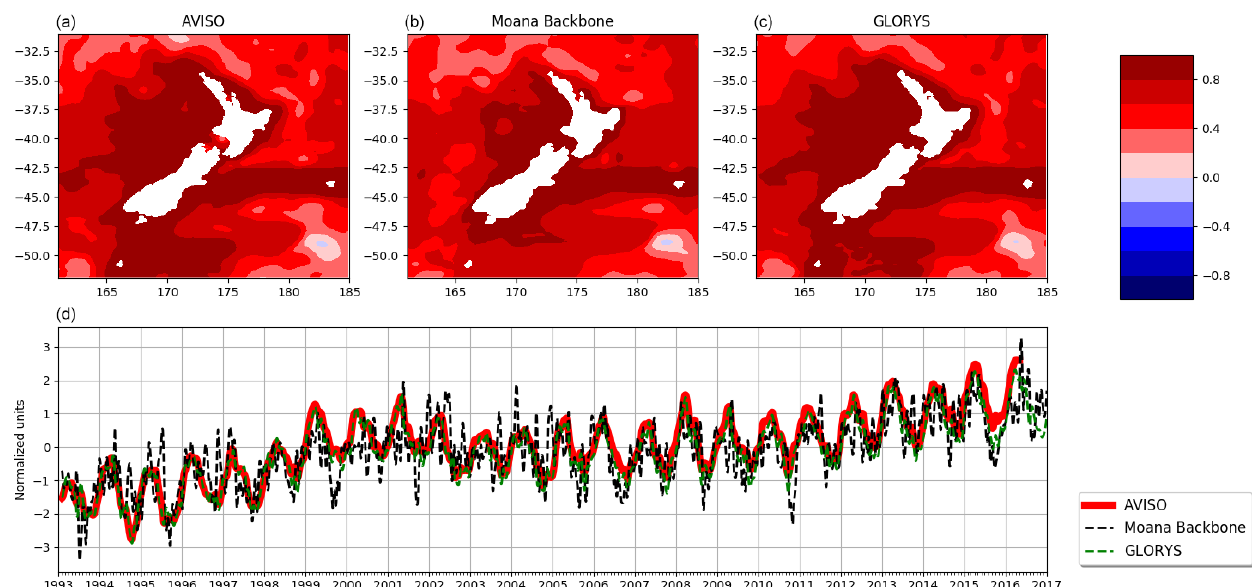
Figure 4. Empirical orthogonal function (a, b, c) and principal component (d) decomposition of the 40d low-pass filtered SSH from the Moana Ocean Hindcast (a) and GLORYS simulations (b) and the AVISO observational product (c) .